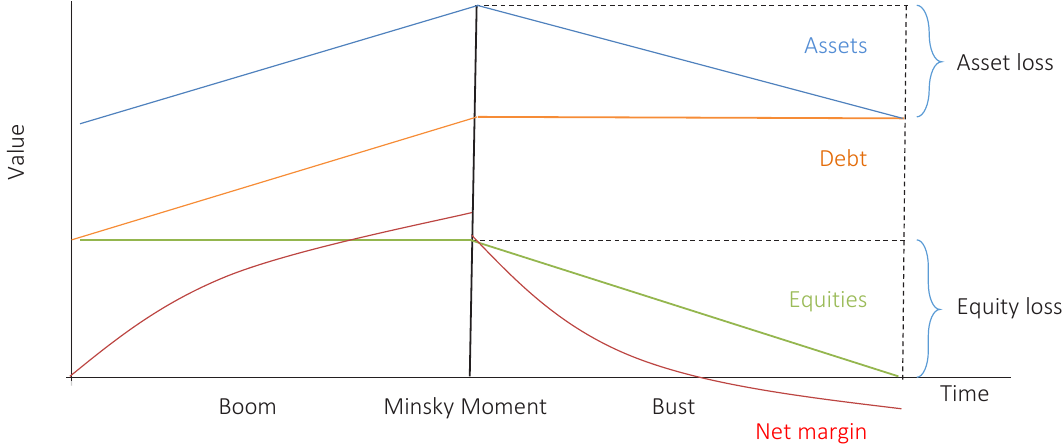
Figure 1. Development of assets linked to the financial instability